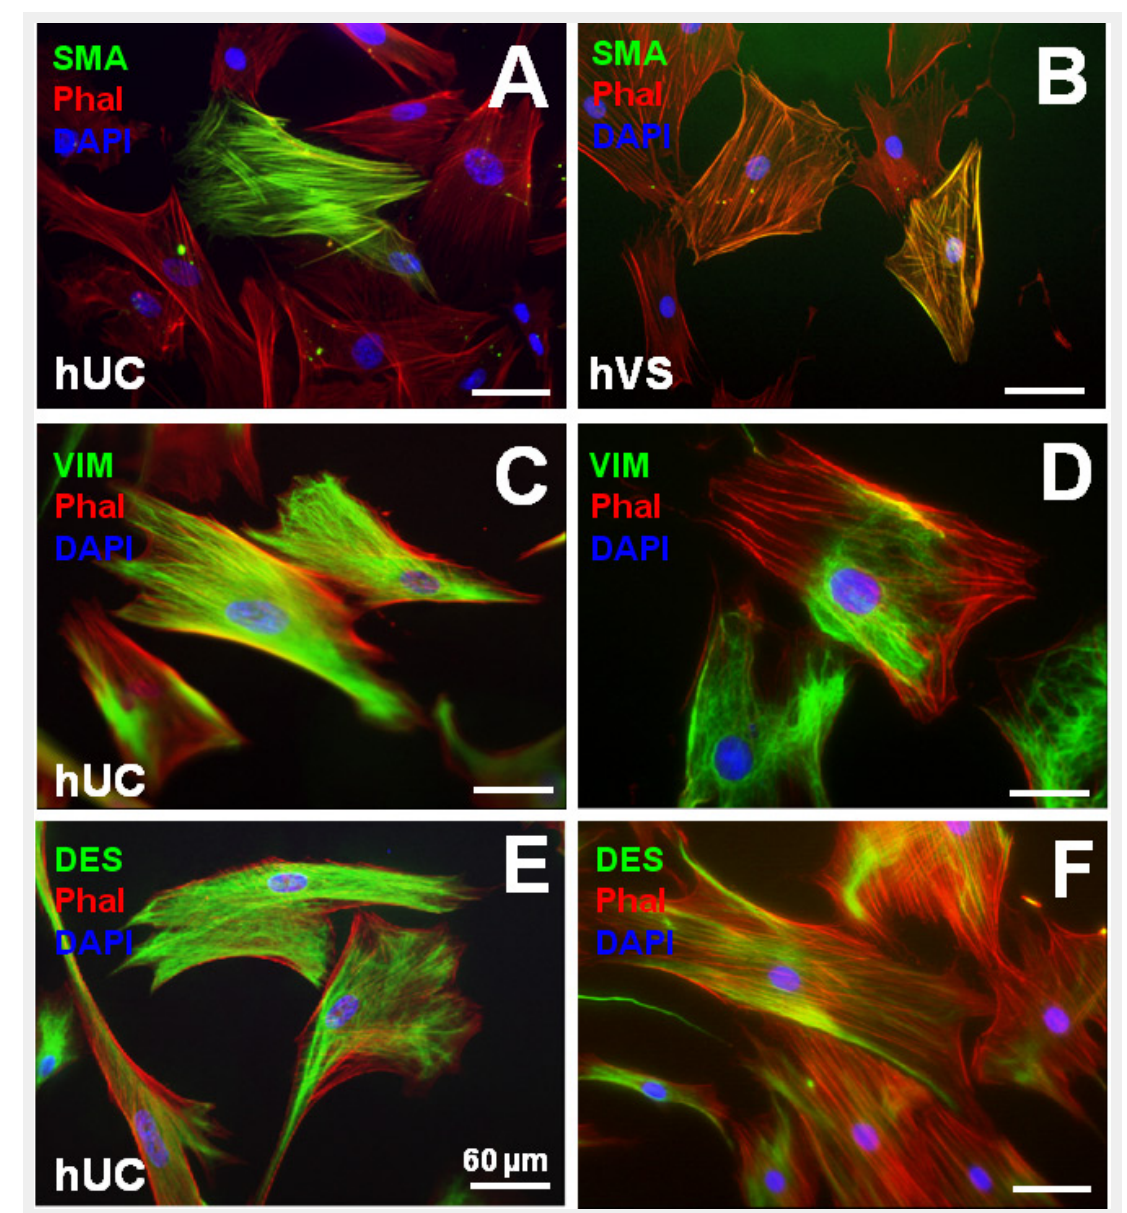
Figure 4 Human umbilical cord Wharton’s jelly-derived myofibroblast-like cells (WMFs) revealed smooth muscle-like phenotypes with positive stainings for vimentin (C), desmin (E) and partially for α-sma (A) similar to mature vascular-derived myofibroblasts (B, D, F). (Reprinted from [48]: Weber B, Schoenauer R, Papadopulos F, Modregger P, Peter S, Stampanoni M, et al. Engineering of living autologous human umbilical cord cell-based septal occluder membranes using composite PGA-P4HB matrices. Biomaterials. 2011;32(36):9630–41. © Elsevier, Oxford, UK, with kind